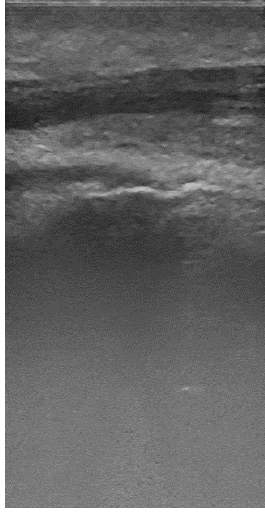
Figure 6. Upper premolar, periodontal ultrasound image, 20 MHz. The images may contain up to five elements: bone, crown, gingiva, periodontal pocket, and